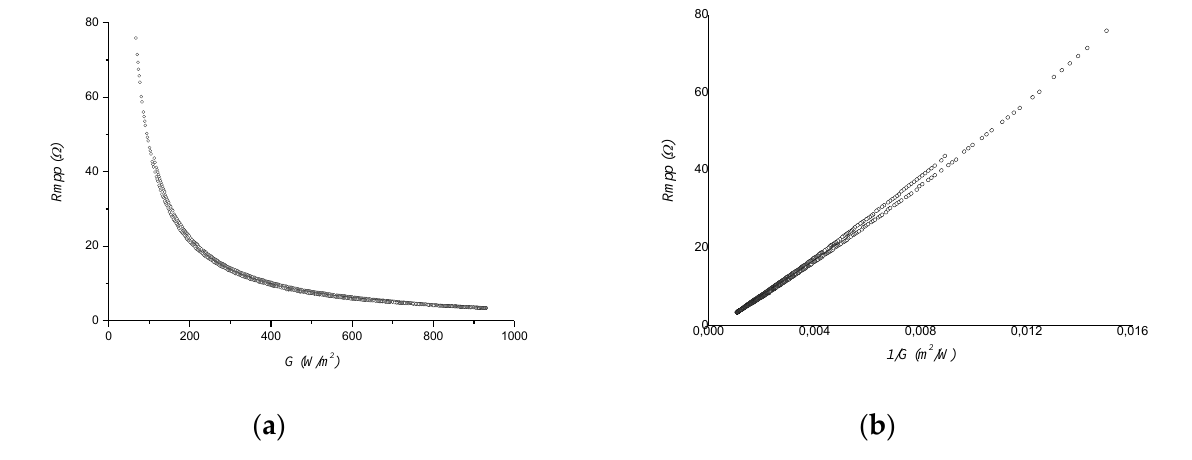
Figure 5. ( a ) R MPP -G and ( b ) R MPP -1/G characteristics for the module ISF-250.